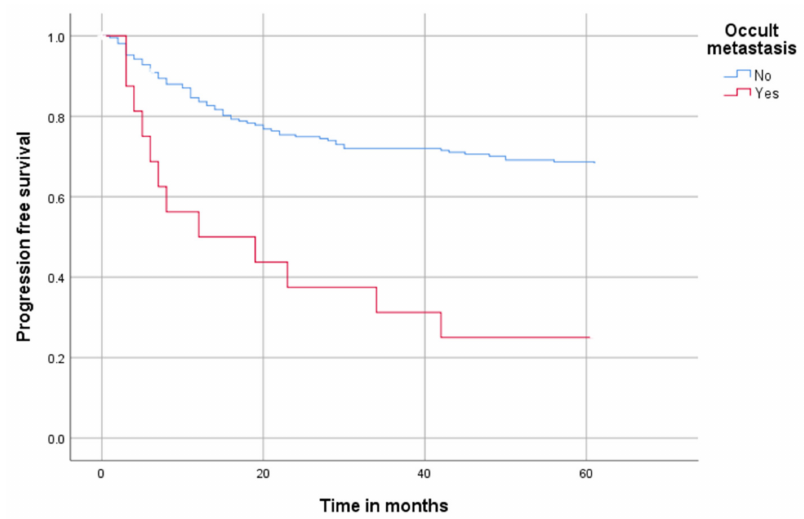
Figure 1. Progression-free-survival in all patients over 60 months; blue marks patients without occult metastasis (patients with N0 and N+ but previously diagnosed via staging; red marks patients with occult metastasis.